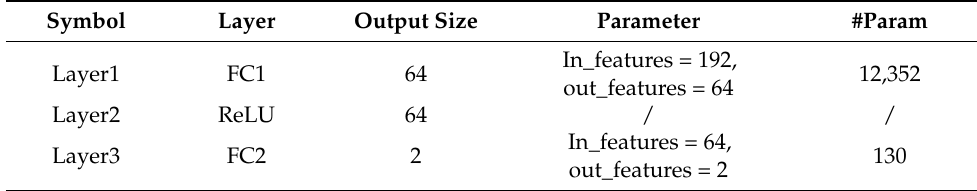
Table 5. Structure of the domain discriminator.